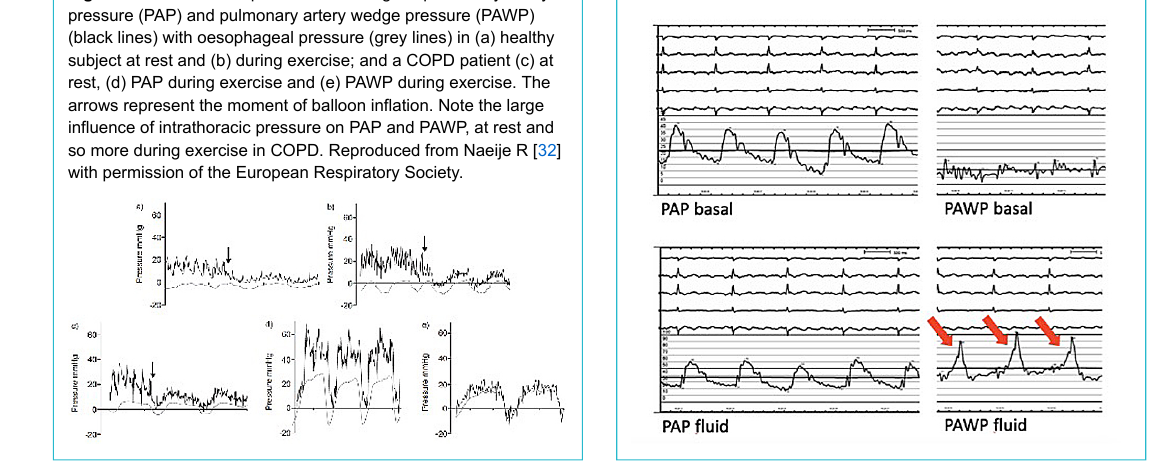
consistent with precapillary pulmonary hypertension (mPAP 25 mmHg, PAWP 10 mmHg). A 500 ml infusion of saline unmasked left heart disease. Here, transpulmonary pressure gradient was 11 mm Hg and diastolic pressure gradient 0 mm Hg. Note the normal basal PAWP and its dramatic increase after fluid challenge (fluid PAWP) with a characteristic V wave (arrows) . The patient suffered from hypertension, diabetes, and atrial flutter (see the electrocar- diographic traces). He had mitral insufficiency and was classified as group 2 pulmonary hypertension. Adapted from Lador F [34] with permission from the publisher. © Georg Thieme